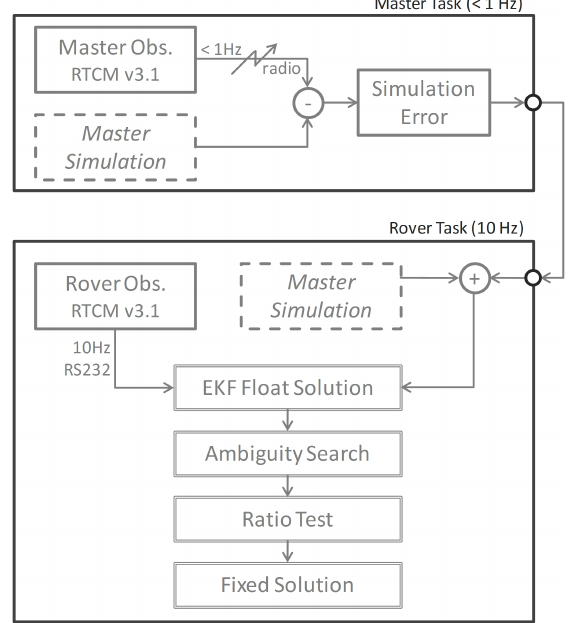
Figure 5: The data links of the direct georeferencing system. transmission rate is 1 Hz. So as not to be dependent on the unre- liable master data transmission and the lesser sampling rate, not the real master observations, but simulated master observations are used as input for the RTK-GPS processing. This simulation is based on the fixed and known coordinates of the master